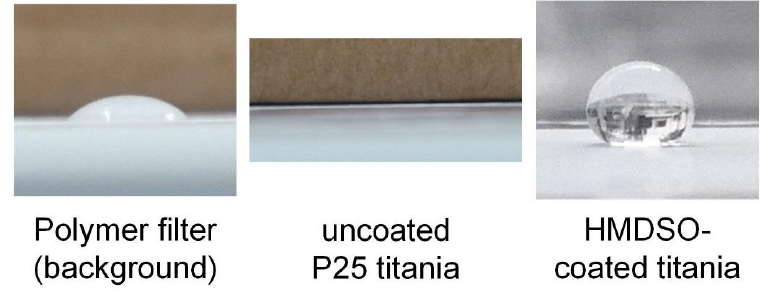
Figure 10. Photographs of water droplets on the filter, on uncoated titania particles on the filter and on HMDSO-coated titania on the